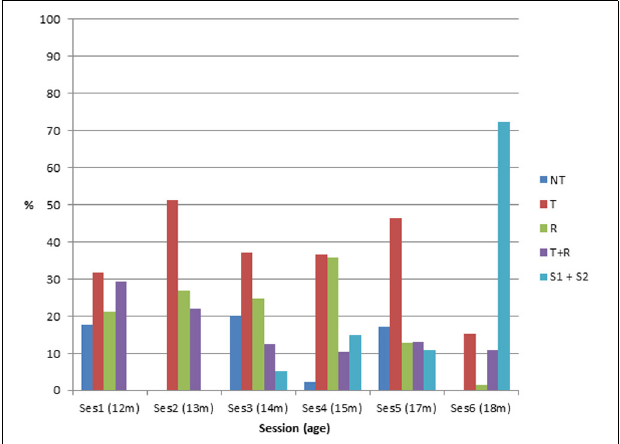
FIGURE 6 | Distribution of the five categories of behavior at C4–C5 as a function of session. (NT, refusal; T, interested in toy only; R, interested in rake only; T + R, interested in connection between rake and toy but not for retrieval; S1 + S2, partial or total success at toy